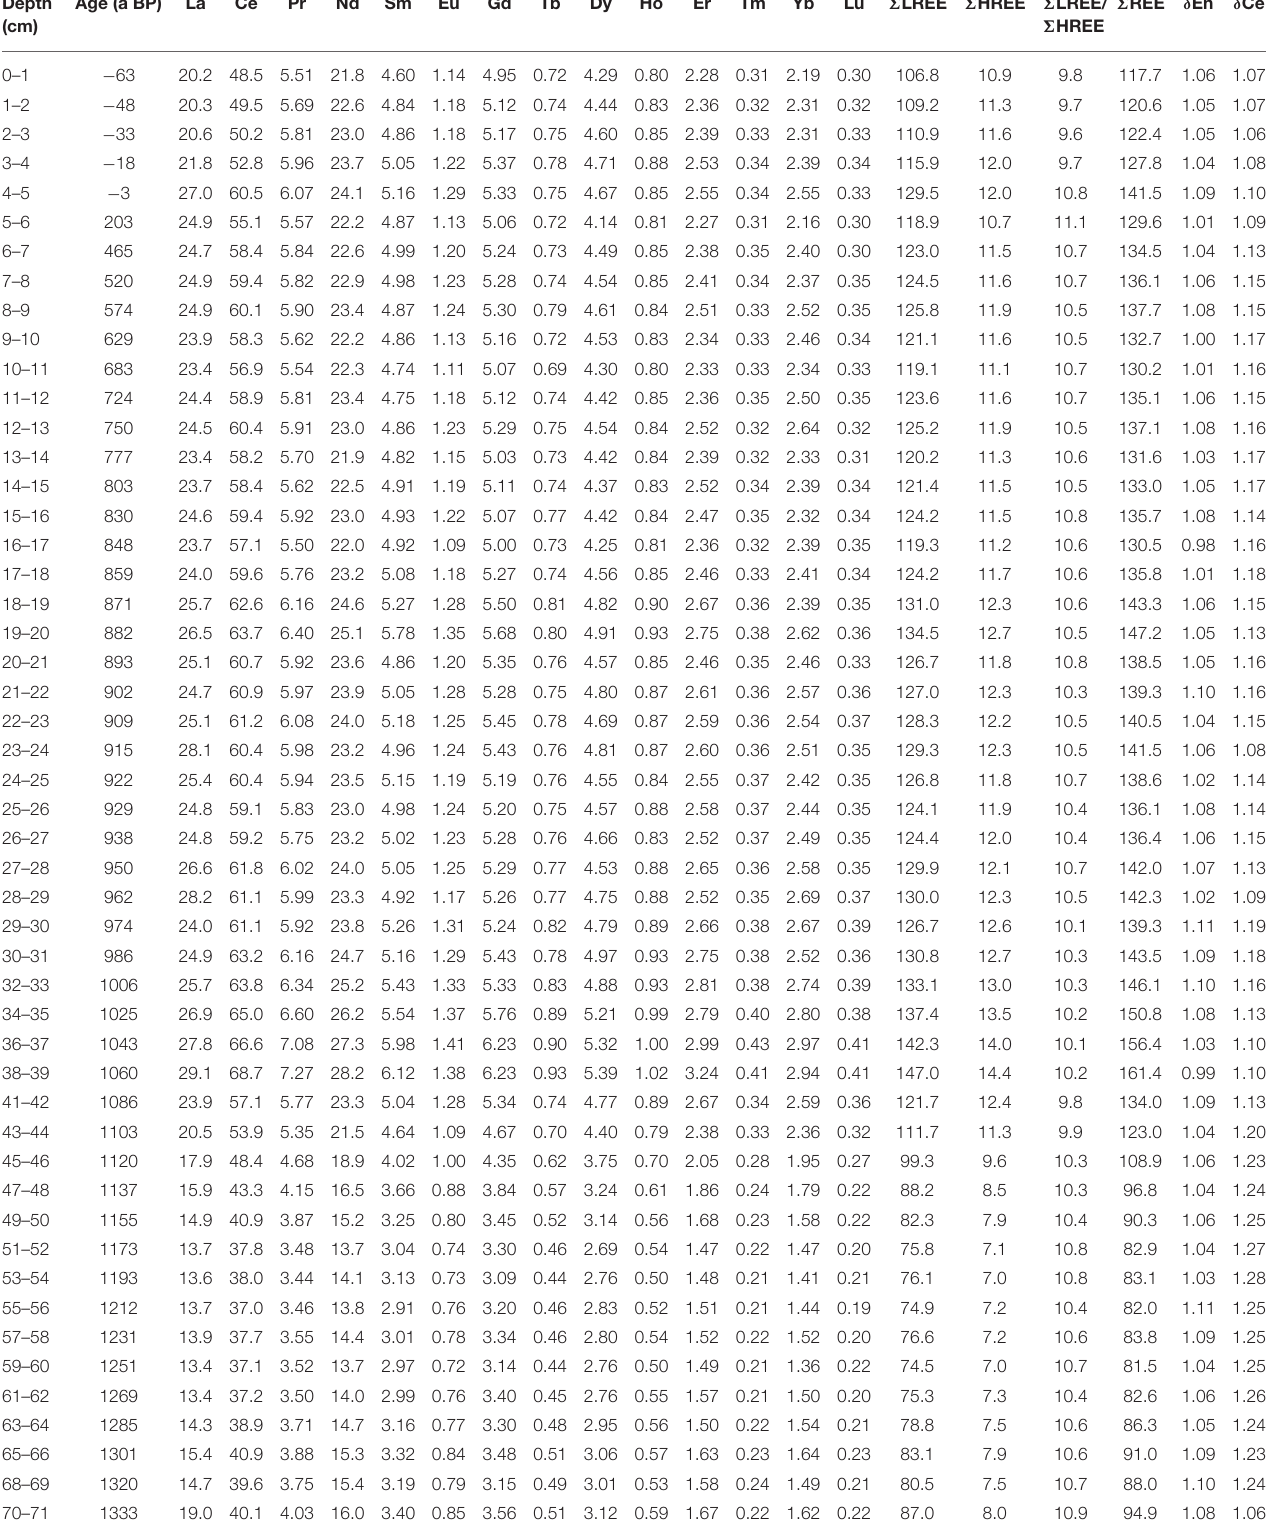
TABLE 2 | Rare earth elements of the Manzherok Lake core samples. Depth